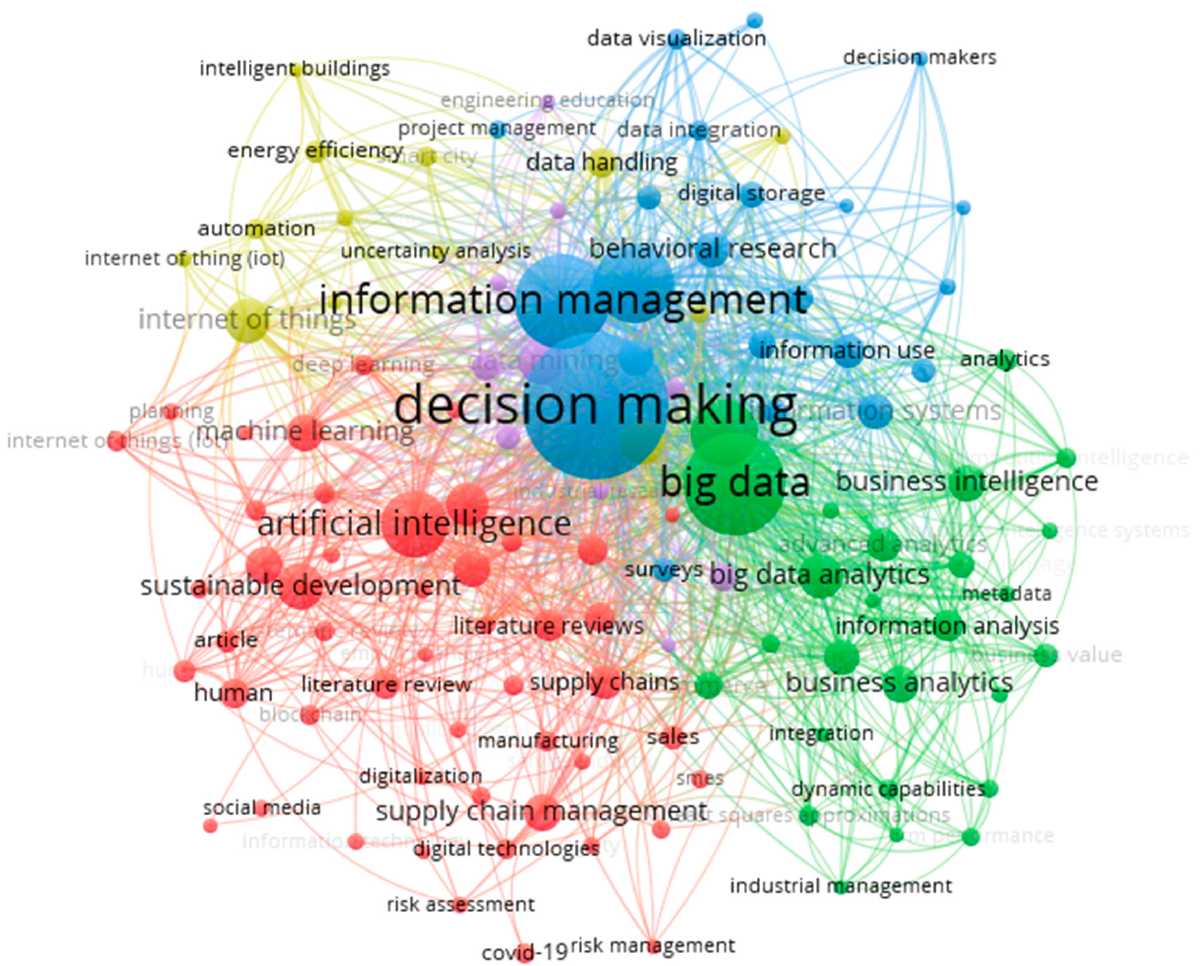
Figure 9. Network visualization—co-occurrence of author keywords.